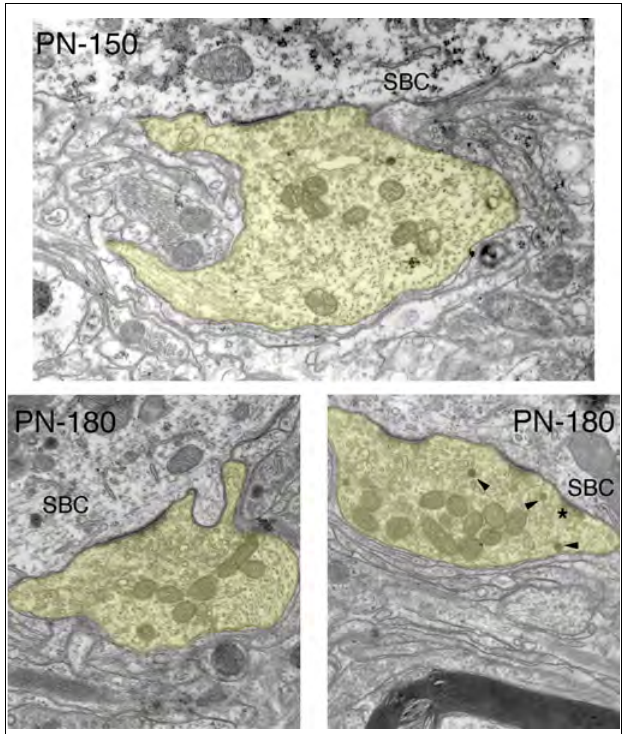
FIGURE 10 | Electron micrographs of endbulbs from adult deaf cats. These endbulbs typically exhibit a mixture of abnormal synapses characterized by long, fl at PSDs and normal (*) ones. Postsynaptic coated vesicles (arrows) at varying stages of endocytosis can infrequently be seen at the SBC-endbulb interface. Scale bar equals 1